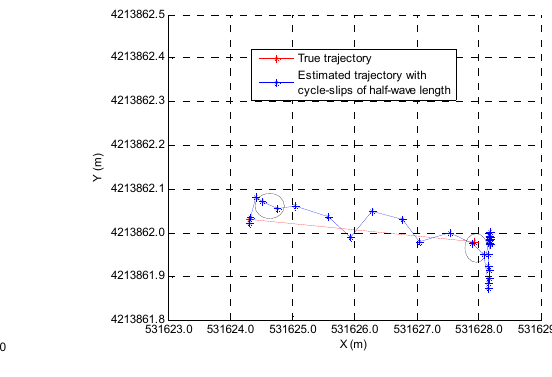
Figure 18. Kinematic experiment of cycle-slip detection by the carrier phase double-difference cycle-slip detection method.